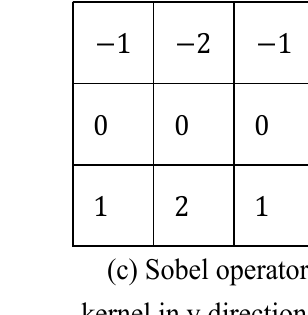
Figure 3. Sub-window of an image and Sobel operator kernel.